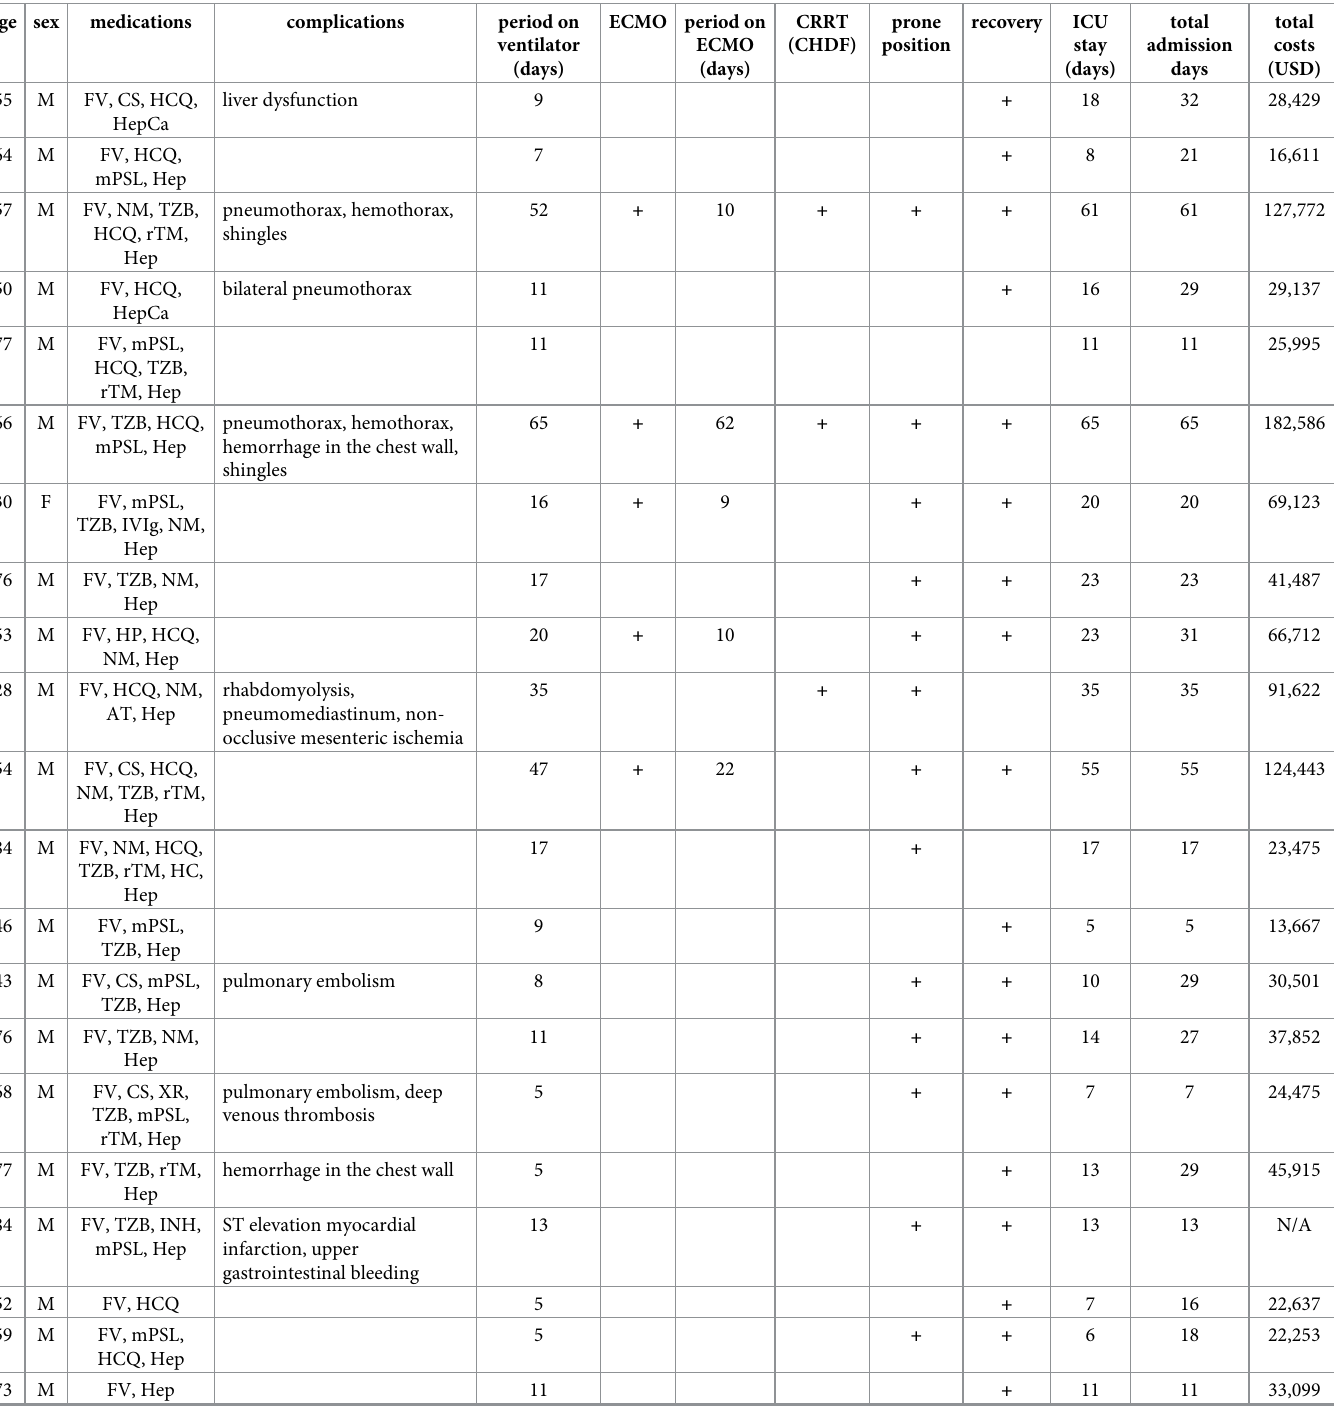
Table 3. Treatments, complications, clinical course, and medical costs for the patients with PCR-positive for SARS-CoV-2 managed on ventilator in intensive care units. age